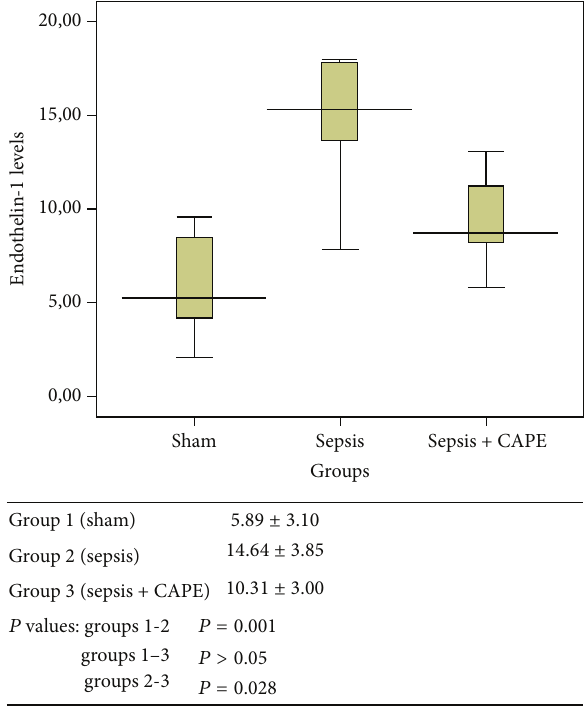
Figure 1: Serum ET-1 level (pg/mL) was described as mean value ± SD for all groups.